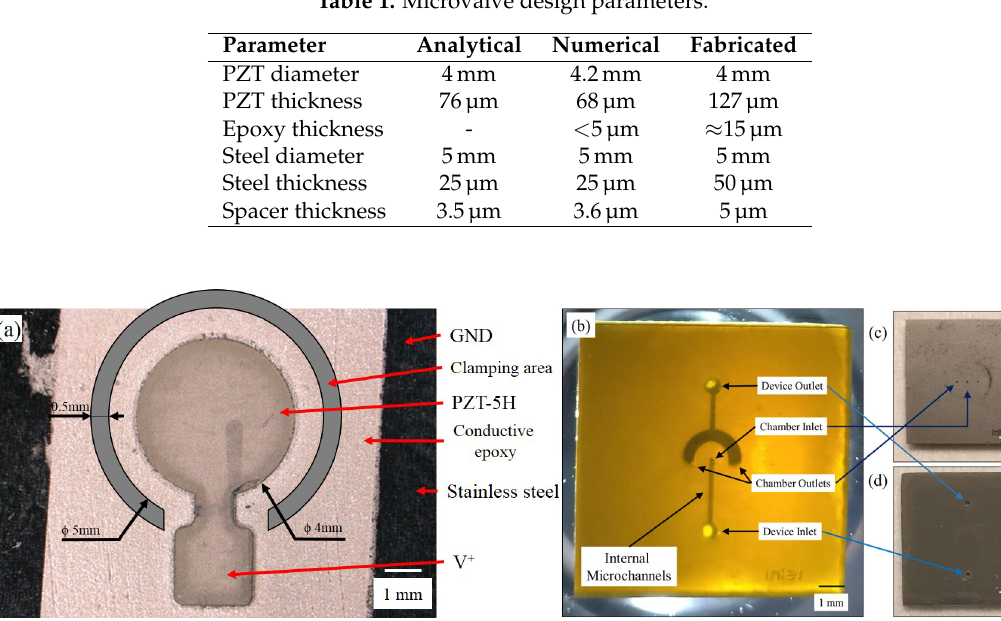
Figure 4. ( a ) Fabricated microactuator with a laser-cut PZT part bonded to a stainless steel membrane using conductive epoxy. The region where the actuator is clamped by the holder is shown in grey. ( b ) 3D printed buried microchannels with inlet and outlet connections. The channels become visible when illuminated with a bright light source underneath. ( c ) Top view of microchannels ( d ) Bottom view of microchannels.